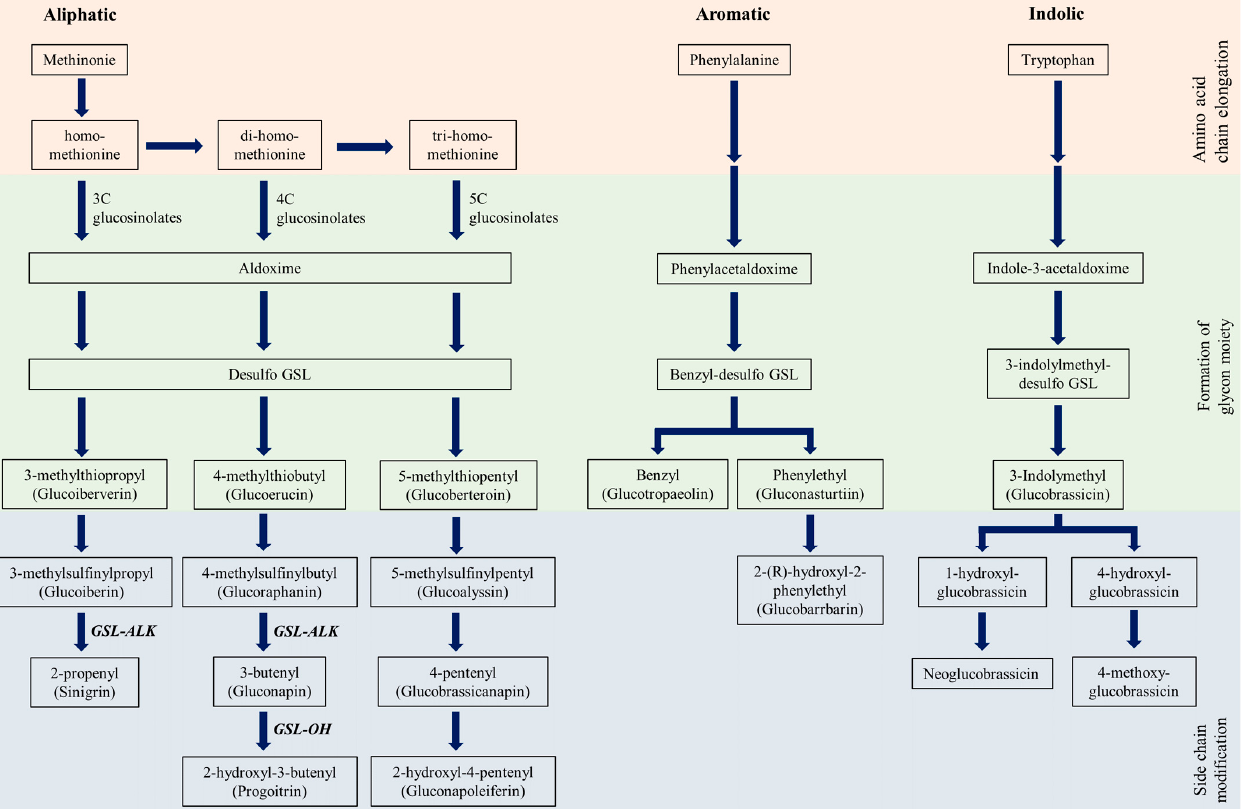
Figure 2. Three major biosynthesis pathways of glucosinolate in Brassicaceae. Flow chart, which can